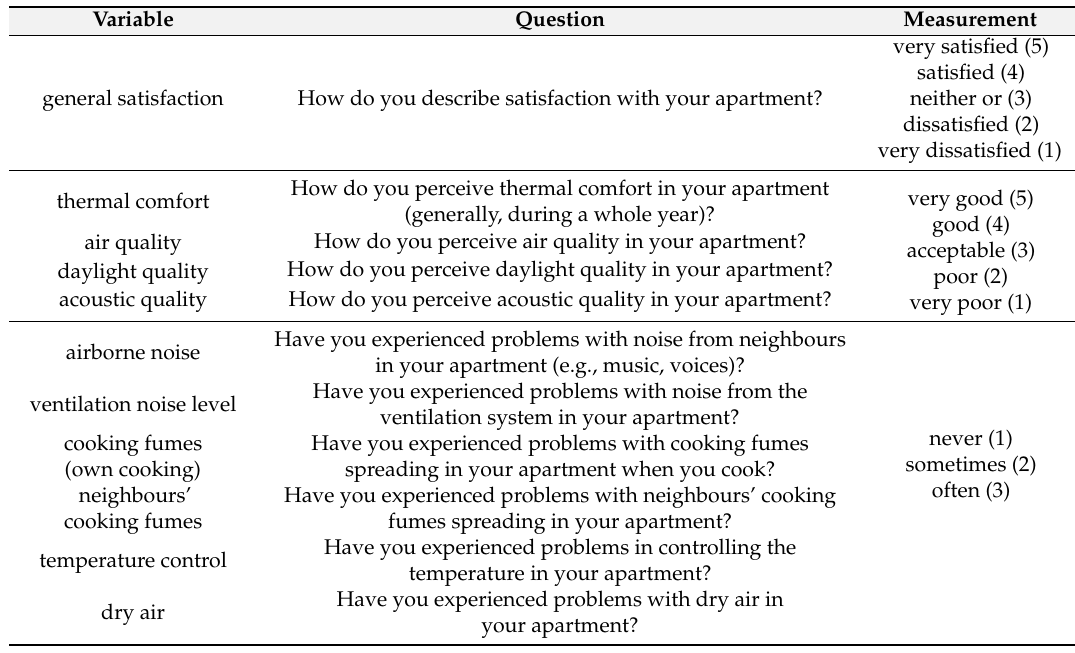
Table 2. Variables and survey questions, answers and assigned